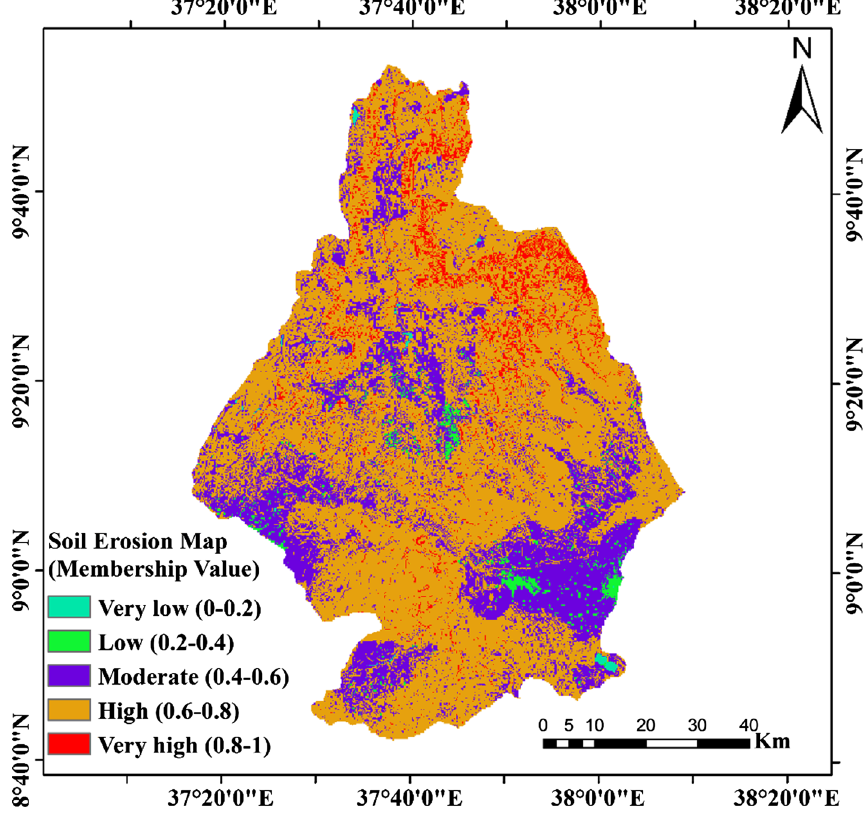
Fig. 12 Final Map of Soil Ero-